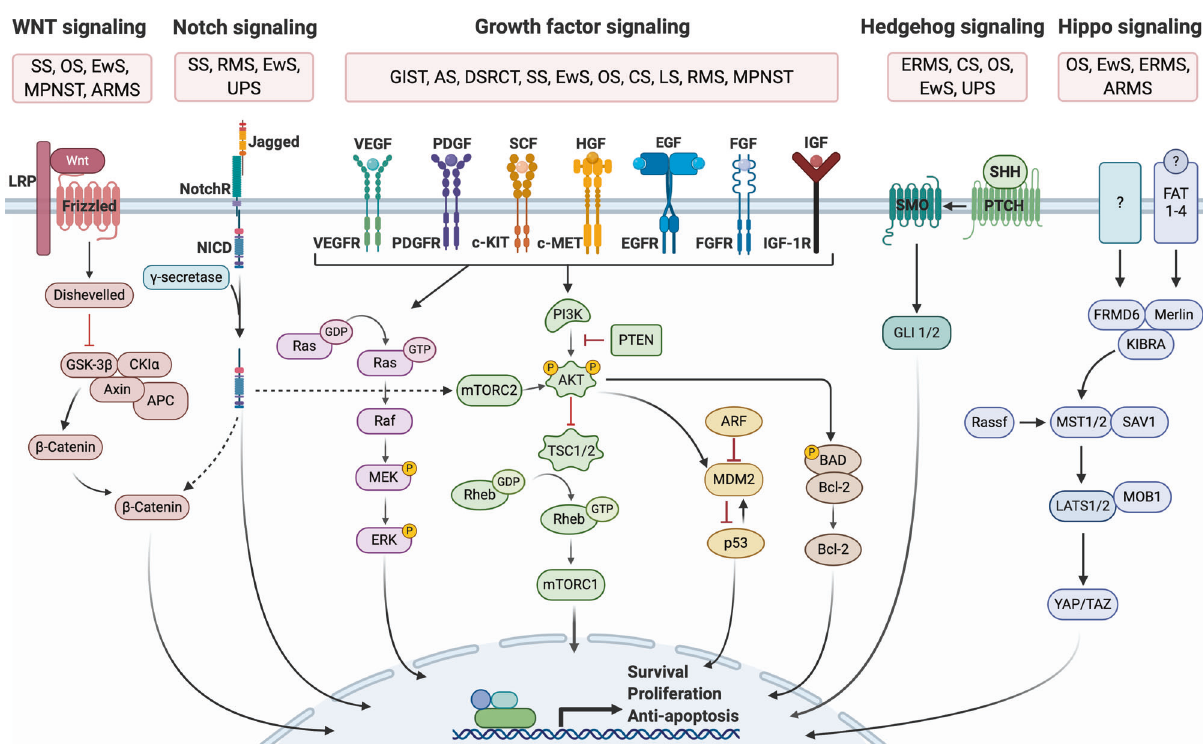
Fig. 4 Schematic illustration of key signaling pathways underpinning sarcomagenesis. Wnt signaling: SS, 271 OS, 272,273 EwS, 62,274 MPNST, 275 – 277 ARMS, 278 Notch signaling: SS, 279 RMS, 279 EwS, 62 UPS, 280 ; Growth-factor signaling: GIST, 53 – 55 DSRCT, 51 AS, 31,281 SS, 58 LS, 31 CS, 31 OS, 52 EwS, 62,282 RMS, 57,283 MPNST, 284 ; Hedgehog signaling: UPS, 280 OS, 63 , ERMS, 64 CS, 65 EwS, 62 ; Hippo signaling: OS, 138,285 EwS, 286,287 ERMS, 288 ARMS. 289 Abbreviations : ARMS alveolar rhabdomyosarcoma, AS angiosarcoma, CS chondrosarcoma, DSRCT desmoplastic small round cell tumors, ERMS embryonal rhabdomyosarcoma, EwS Ewing ’ s sarcoma, GIST gastro-intestinal stromal tumor, LMS leiomyosarcoma, LS liposarcoma, MPNST